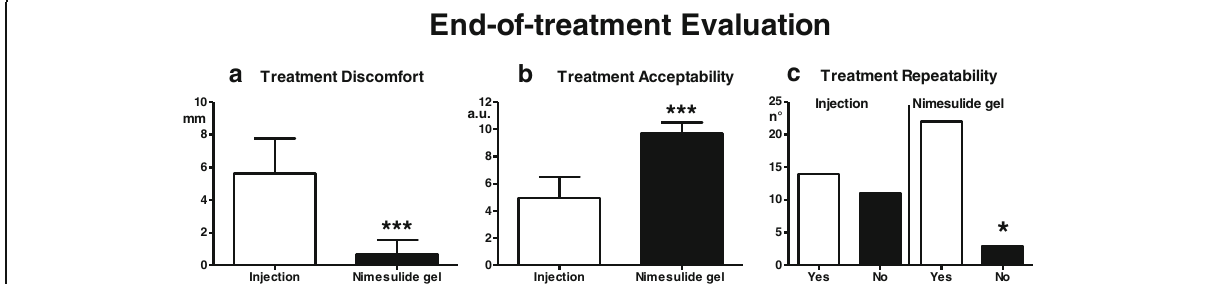
Fig. 5 End-of-treatment evaluations. Discomfort from treatment (a), acceptability of treatment (b), willingness to repeat the treatment (c) of the TrP (injection or nimesulide gel). * = p < 0.05; *** = p < 0.001: comparison between injection group and nimesulide gel